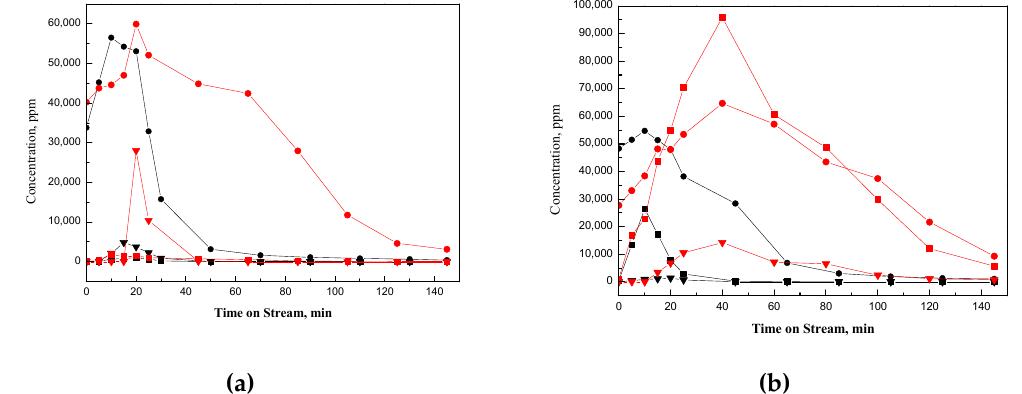
Figure 4. ( a ) Ethanol desorbed and species formed in temperature programmed regeneration of EtOH-laden NaY-SiO 2 : ethanol desorbed at high flow rate (black • ), ethanol desorbed at low flow rate (red • ), DEE formed at high flow rate (black ▼ ), DEE formed at low flow rate (red ▼ ); acetaldehyde formed at high flow rate (black ■ ), acetaldehyde formed at low flow rate (red ■ ). ( b ) Ethanol desorbed and species formed in temperature programmed regeneration of EtOH-laden Pt/NaY-SiO 2 : ethanol desorbed at high flow rate (black • ), ethanol desorbed at low flow rate (red • ), acetaldehyde formed at high flow rate (black ■ ), acetaldehyde formed at low flow rate (red ■ ), DEE formed at high flow rate (black ▼ ), DEE formed at low flow rate (red ▼ ).